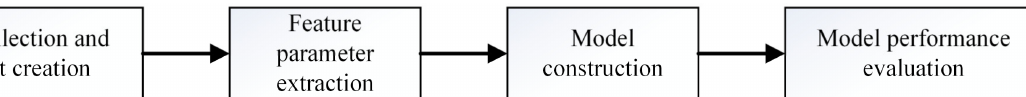
Figure 1. Overall process of the proposed